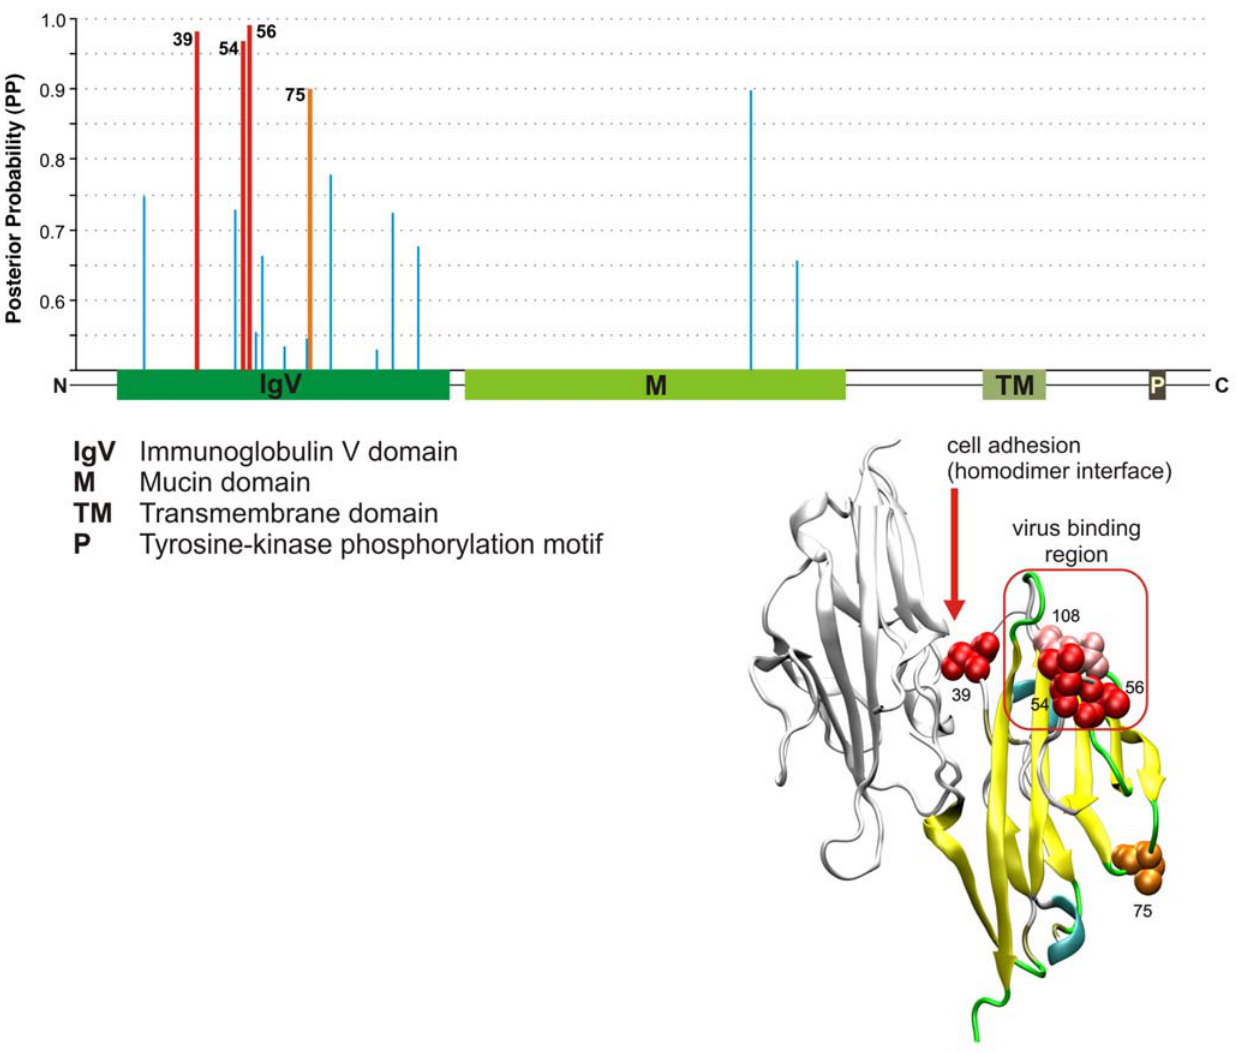
Figure 3. Structural analysis of the HAVCR1 gene. At top is a graph showing the domain structure of the gene and corresponding Bayes Empirical Bayes [83] posterior probabilities (PP) of positive selection, based on our six-species alignments, with sites predicted to be under positive selection (PP . 0.95) in red. At bottom right is a structural diagram (based on the structure of the IgV domain of the mouse gene) showing the interaction between two receptors that have been implicated in the regulation of HAVCR1 ’s immune function. It is thought that clustering of receptors within the same cell surface might facilitate phosphorylation of the cytoplasmic tail, and that interaction between receptors from different cells might be a mechanism for B–T cell adhesion [91]. Predicted residue 39 falls within the region of these receptors, very near residue 37, which directly interacts with the opposite receptor (according to the available mouse structure). In addition, predicted residues 54 and 56 are adjacent to the virus-binding surface (shown in pink), as defined by a polymorphism in macaque [91]. Interestingly, the residue that falls between them (55) appears to be critical for virus-binding at the homologous loop in the CEA coronavirus receptor [91]. Residue 75 in the IgV domain also shows evidence of positive selection (PP . 0.90, shown in orange) but its function is